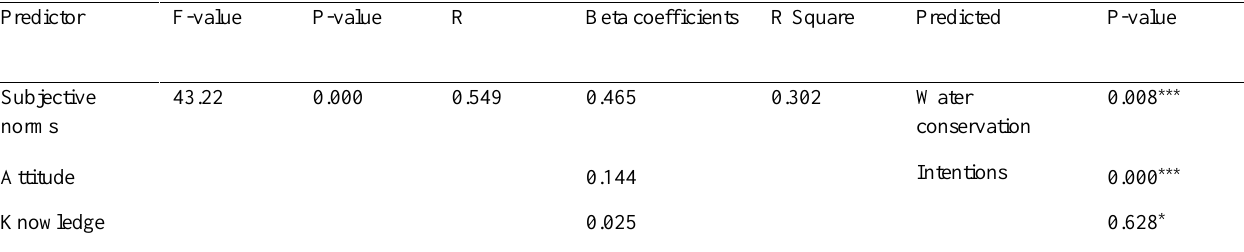
Table 7: Multiple regression on predictors of water